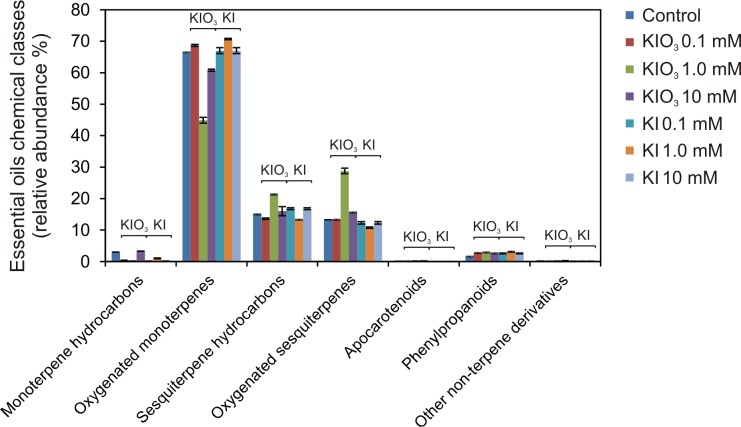
Essential oil composition of basil plants grown in open field.The behavior of the chemical classes of the volatile organic compounds was detected in the leaf essential oils extracted from basil samples treated with KI or KIO3 (0, 0.1, 1.0 and 10 mM).